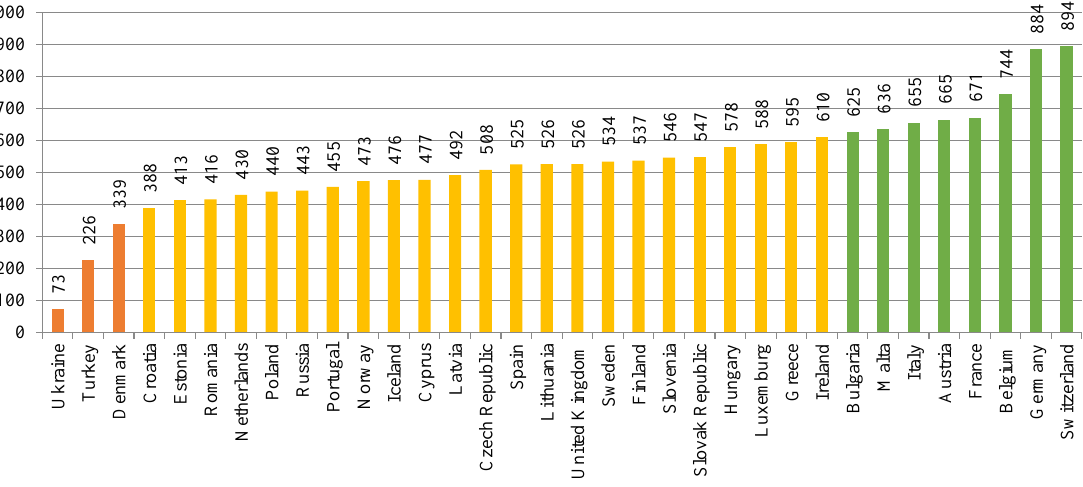
Fig. 6. Level of pharmaceutical expenditure in 2019 (USD per capita)